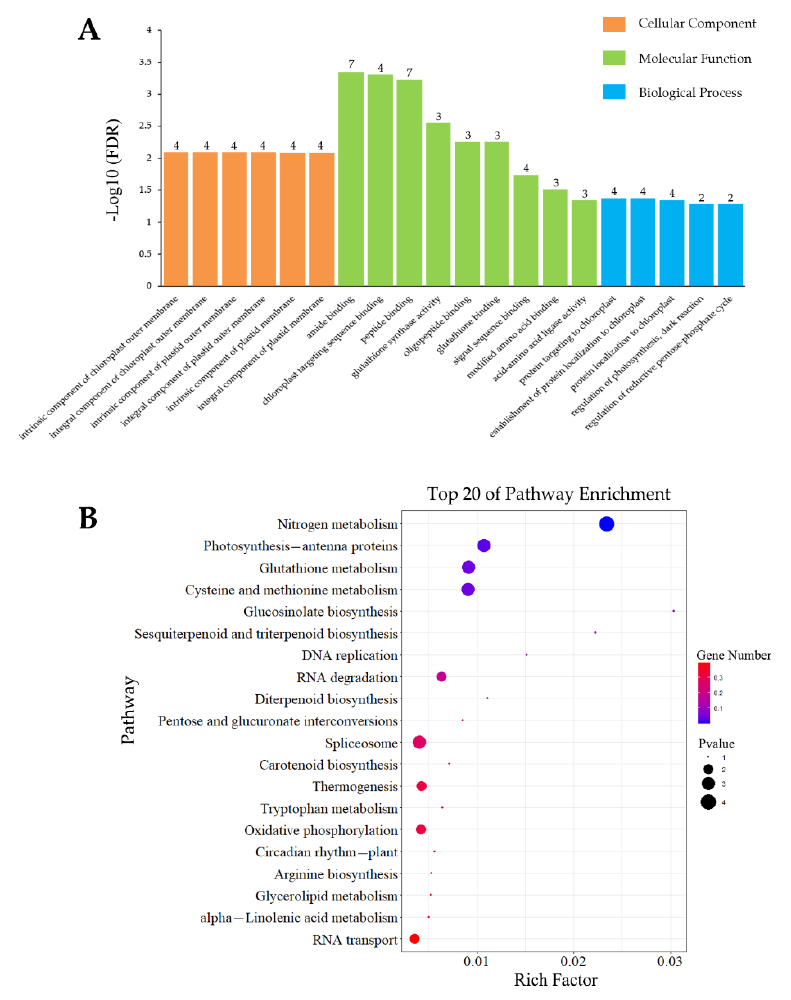
Figure 6. GO ( A ) and KEGG ( B ) analysis of DEGs co-induced by inoculation and wounding. 3.5. Transcription Factors (TFs) in Response to Inoculation and Wounding in P. sylvestris var. mongolica